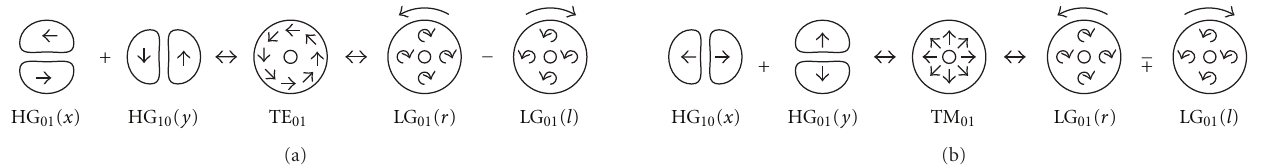
Figure 21: The conversion between scalar and vector LG beams. (a) Azimuthally and (b) radially polarized beams. x and y in the parentheses for linearly polarized HG beams indicate the polarization direction. r and l in the parentheses for circularly polarized LG beams indicate right- and left-hand polarizations, respectively. HG: Hermite-Gaussian beam, LG: Laguerre-Gaussian beam.